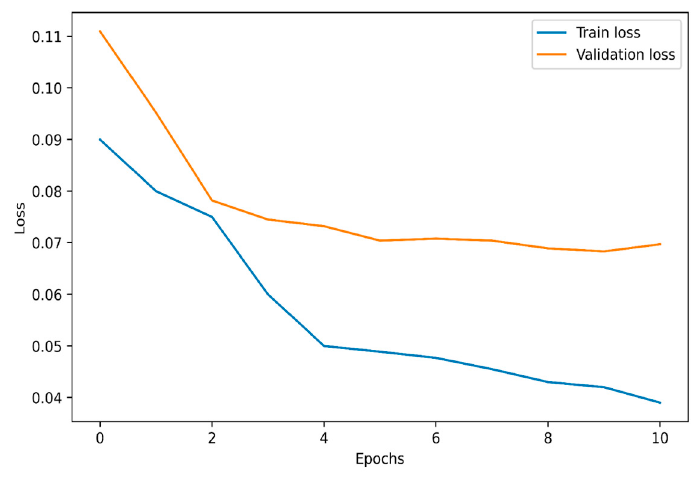
Figure 7. Loss plot for binary classification (Normal vs. Abnormal).